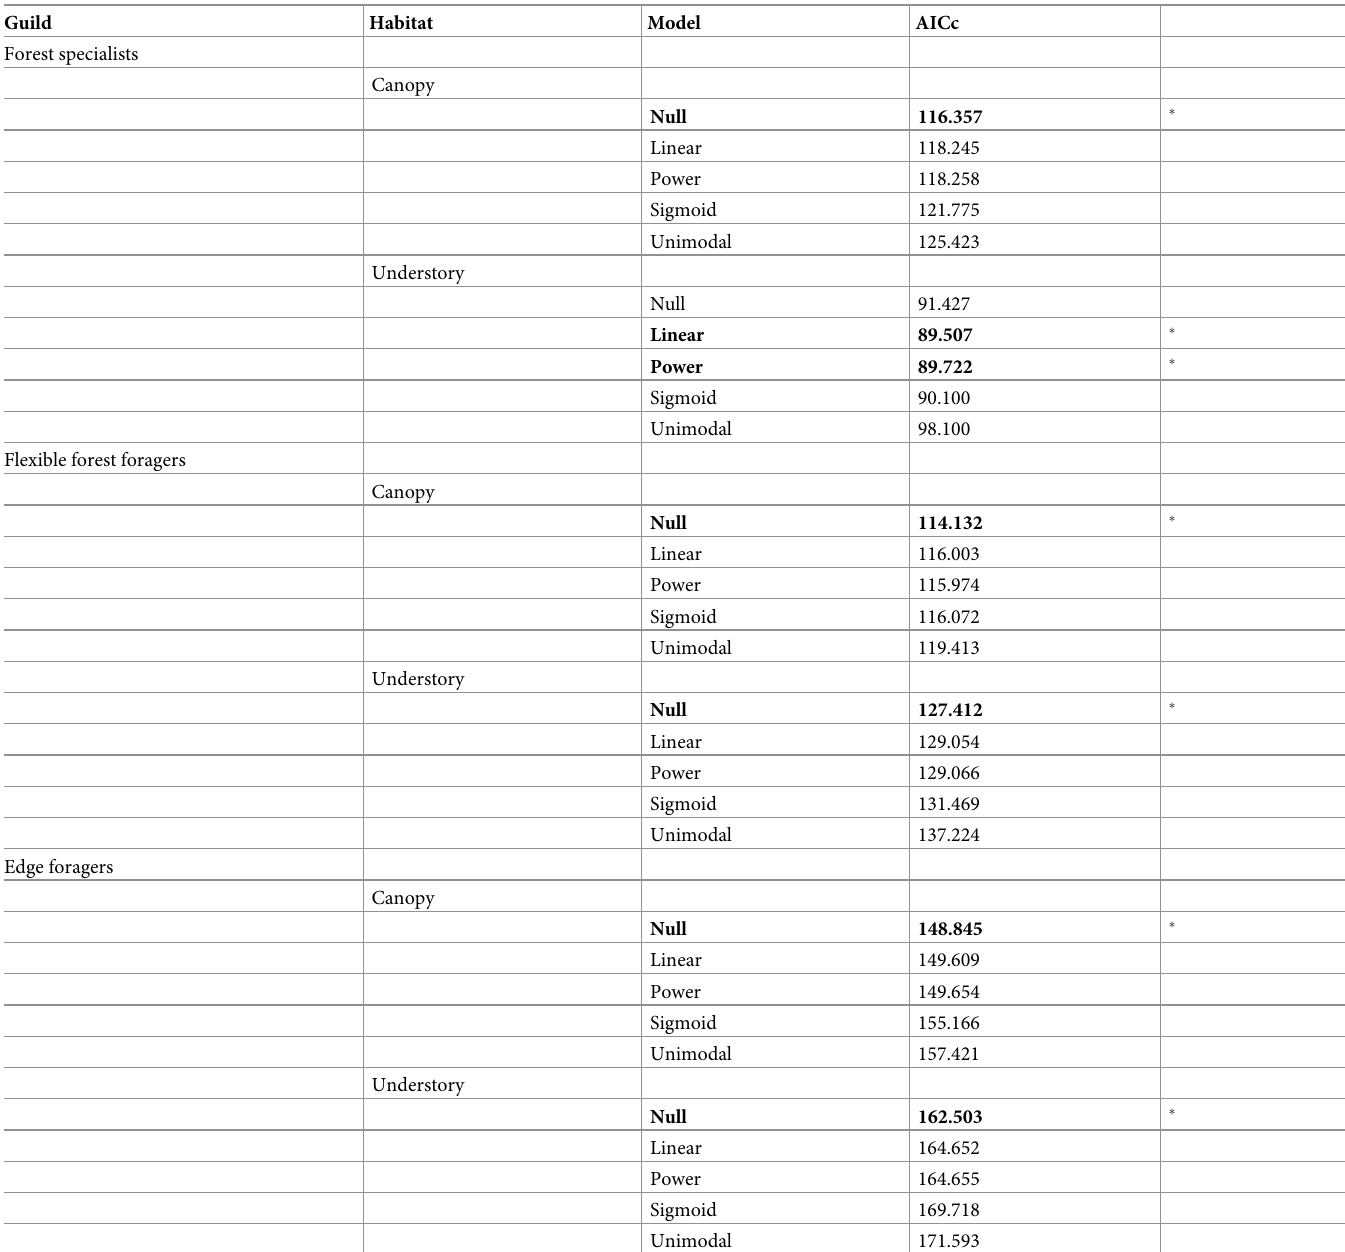
Table 2. Comparison of model fit using Ewers and Didham’s (2006) edge effect